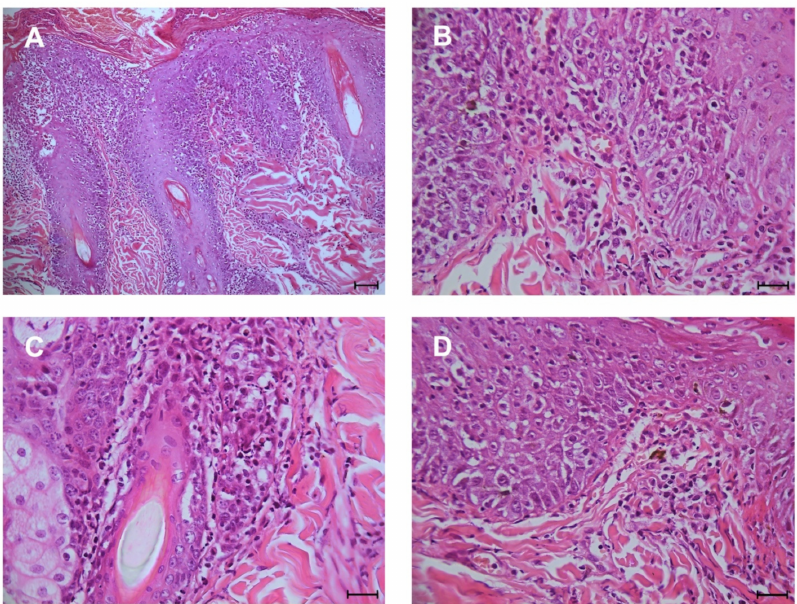
Figure 1. Histopathologic features of DLE. ( A ) interface dermatitis (bar 75 µ m); ( B , C ) infiltrate of plasma cells and lymphocytes within dermo-epidermal junction and hydropic degeneration of keratinocytes of stratum basale (scale bar 25 µ m); ( D ) scattered macrophages contain melanin (pigmentary incontinence) within the superficial dermis (scale bar 25 µ